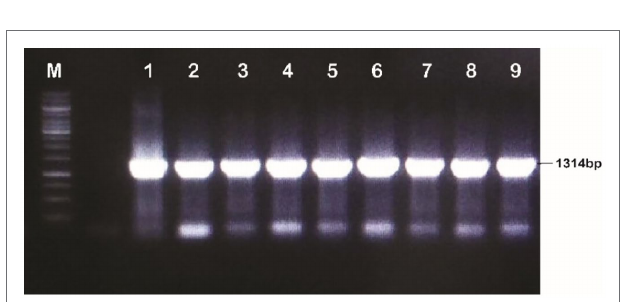
FIGURE 3 | Ligation of Δ Gh_A07G1537 gene into PCAMBIA2300; Lane M: 1 kb molecular weight marker; Lane 1: Gh_A07G1537 ; Lane 2: PCAMBIA2300; Lane 3: non-ligated mixture without ligase; Lanes 4–6: ligation of MBI7747 ( Gh_A07G1537 ).